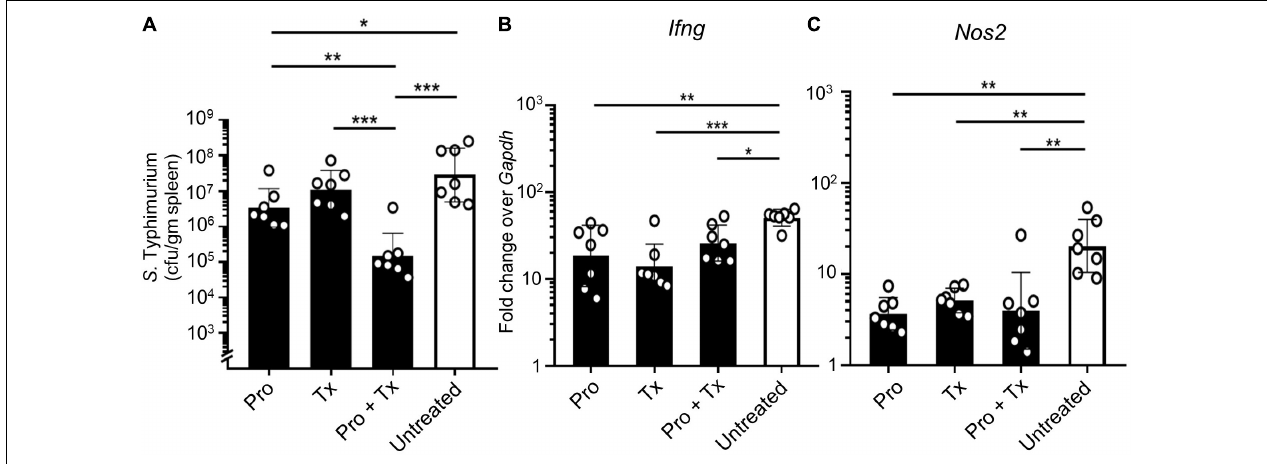
FIGURE 8 | Probiotic L. reuteri KUB-AC5 attenuates a systemic dissemination of STM. AC5-fed mice were divided into three groups (Pro, Tx, and Pro + Tx, black bar) and one untreated group (white bar). Mouse spleens were harvested at day 4 post infection and homogenized for STM cfu/gm determination (A) . Fold change of Ifng and Nos2 genes in mouse spleen was calculated by qPCR ( B,C , respectively). All genes were analyzed with the comparative Ct method over the housekeeping gene Gapdh . Bars represent geometric means ± SD. * P < 0.05, ** P < 0.01, and *** P < 0.001 compared to all other